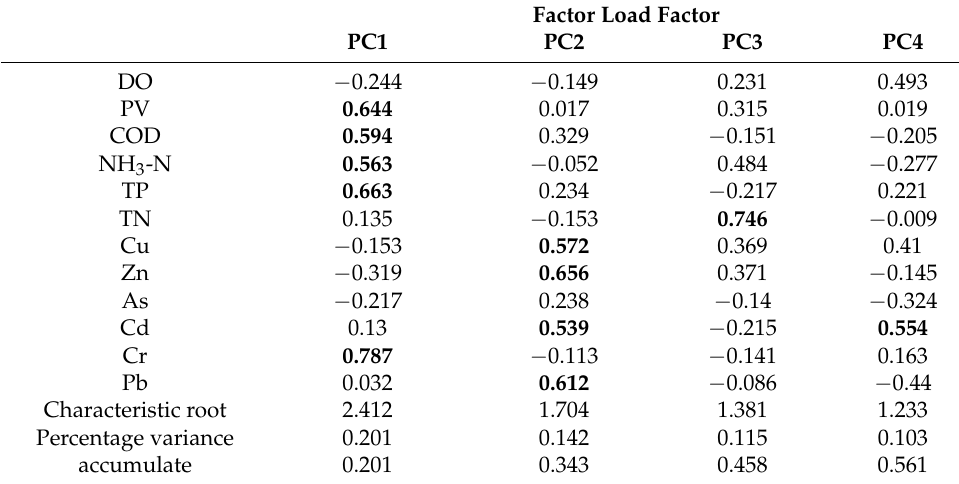
Table 8. Results of